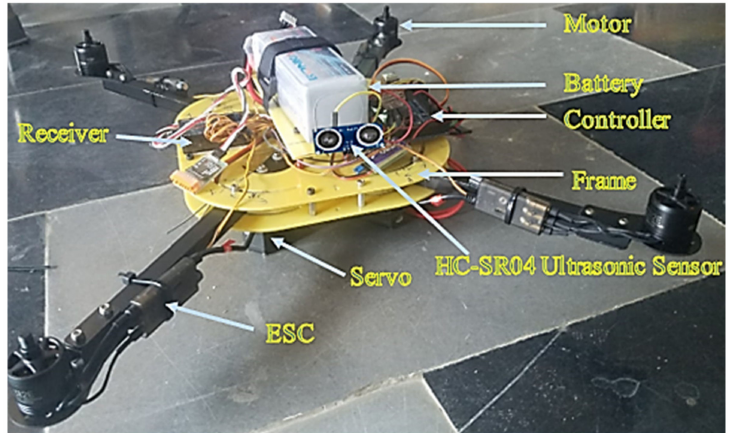
Figure 7. Developed